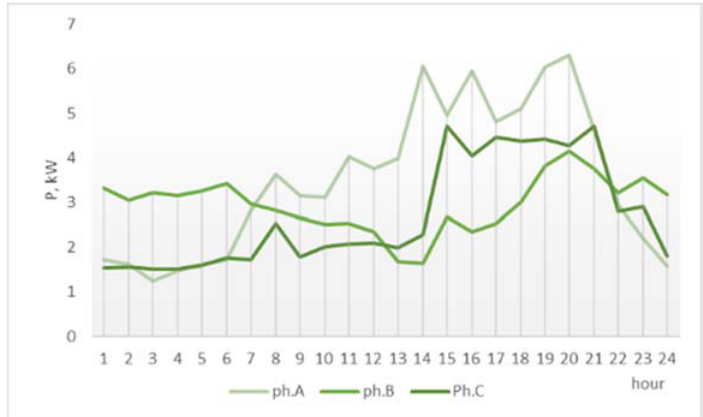
Figure 13. Demand in network R121.